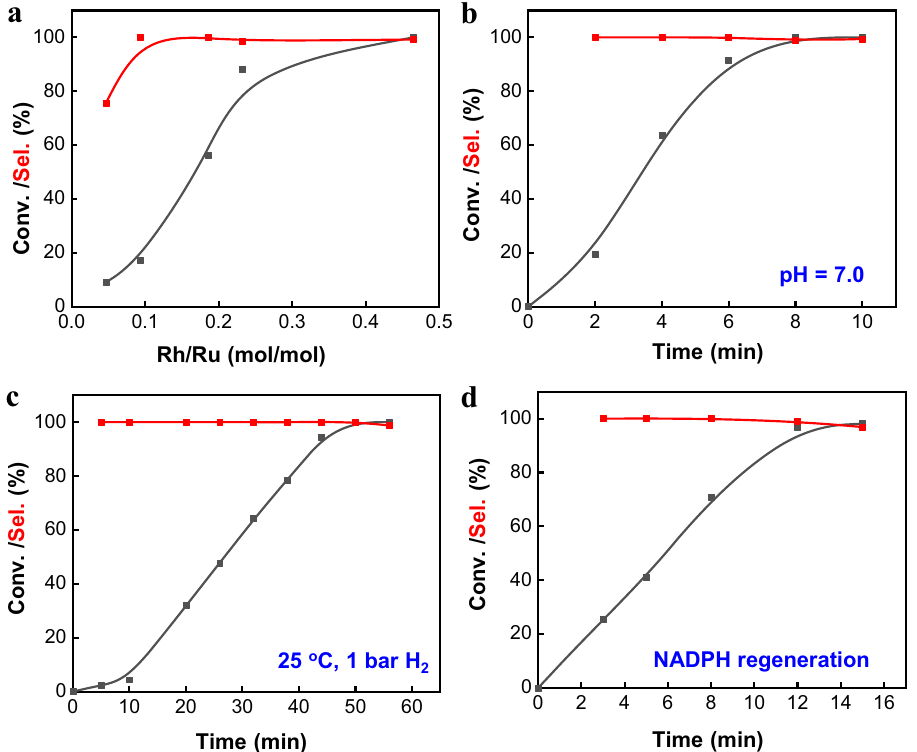
Fig. 2 | Catalytic performance of Ru/TiO 2 @10TP-TTA & 1. NAD + hydrogenation ( a ) with different Rh/Ru molar ratio with a fi xed Ru amount of 0.29 μ mol, 6min, b , c under varied conditions, (d) in NADP + hydrogenation. The reaction